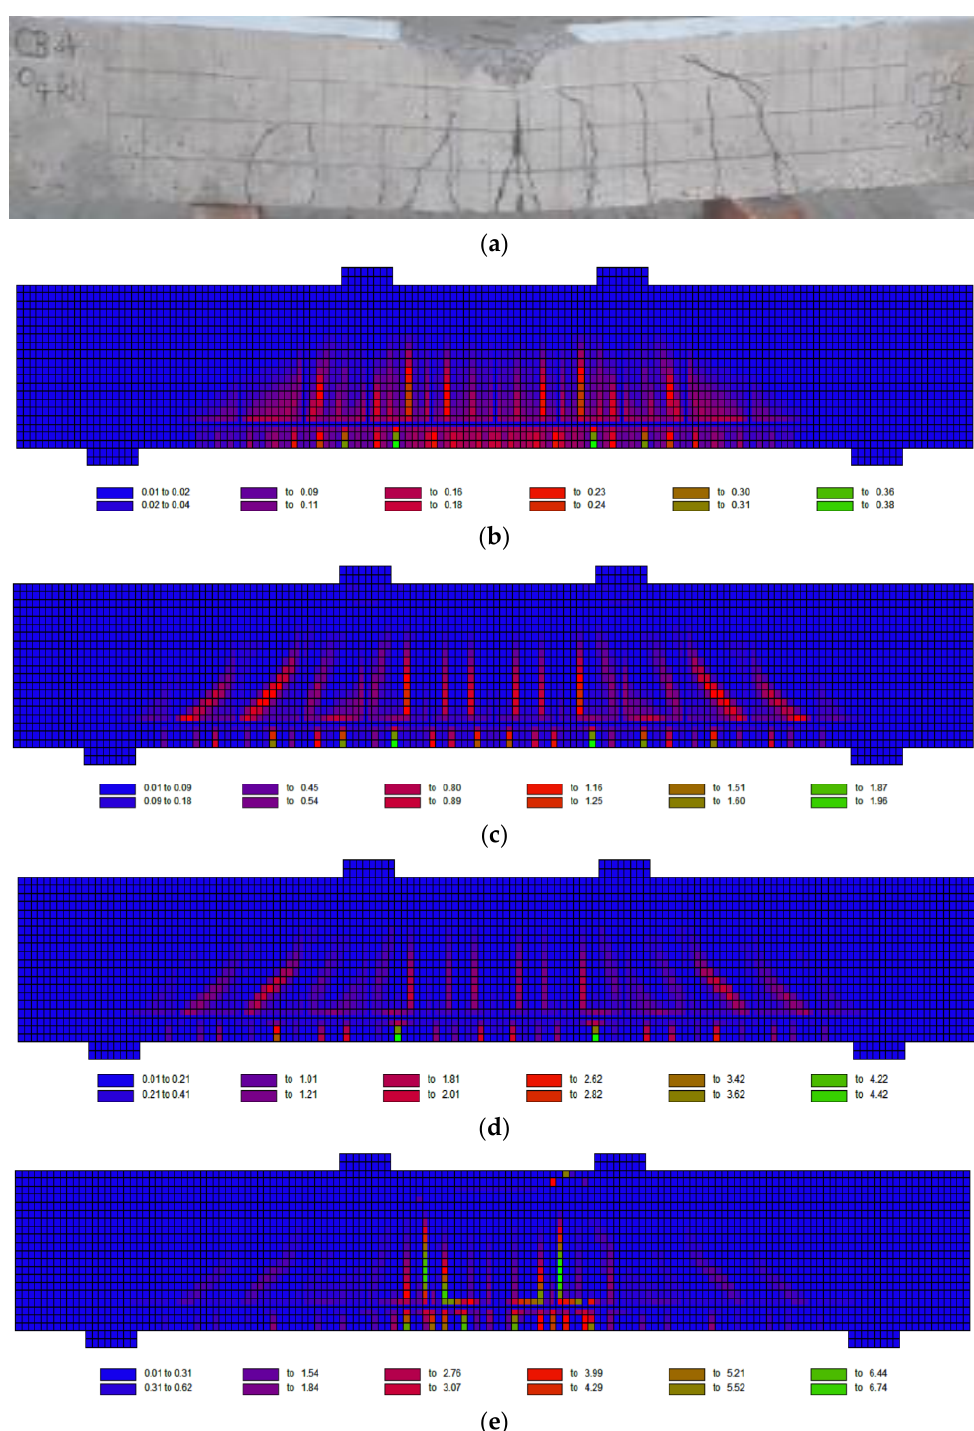
Figure 20. Crack Width (mm) and Failure Mode of Specimen (CBA): ( a ) Experimental failure mode [7]; ( b ) Cracking at 26% of the Ultimate Load; ( c ) Cracking at 65% of the Ultimate Load; ( d ) Cracking at 90% of the Ultimate Load; ( e ) Cracking at 100% of the Ultimate Load.